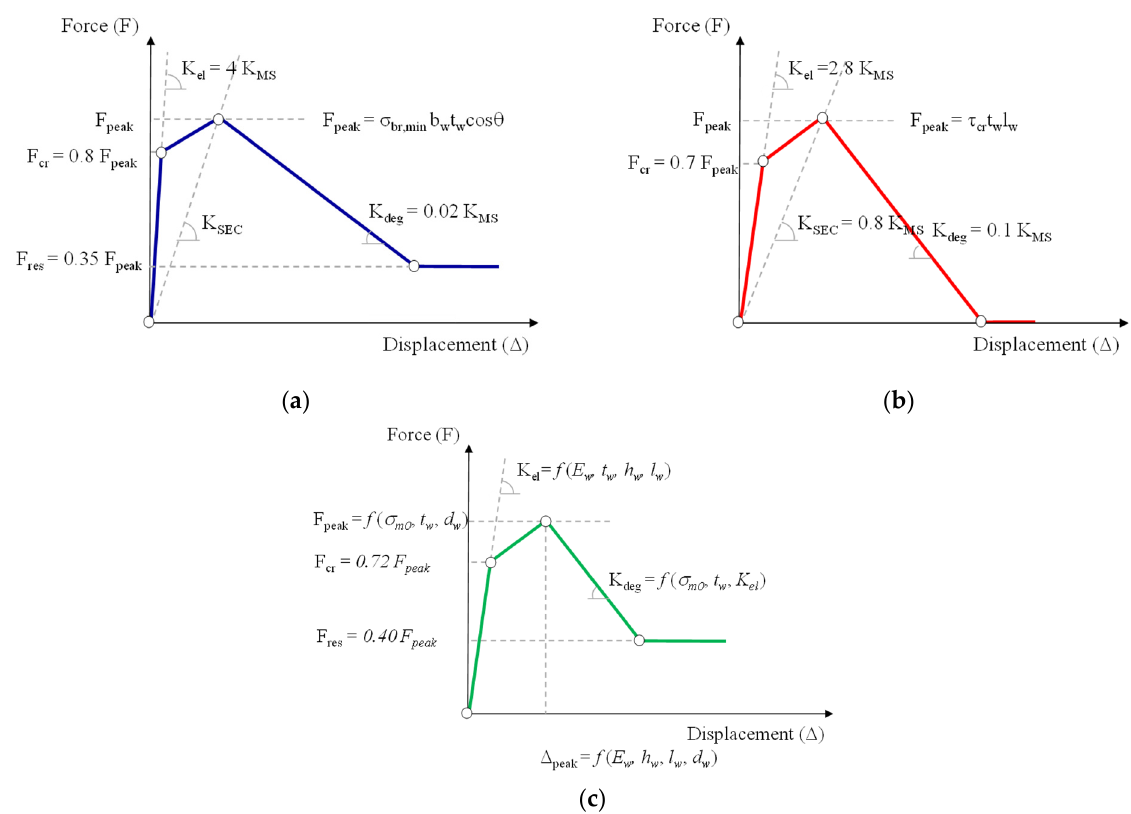
Figure 2. Backbone curves analyzed in this study: adapted from ( a ) Bertoldi et al. [37], ( b ) De Risi et al. [48], ( c ) Huang et al. [49].